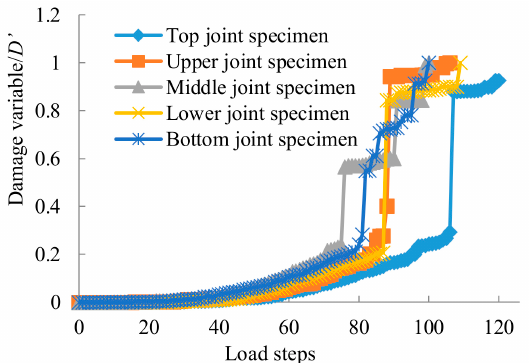
Figure 11. Evolution laws of damage variable D ’ with load steps.